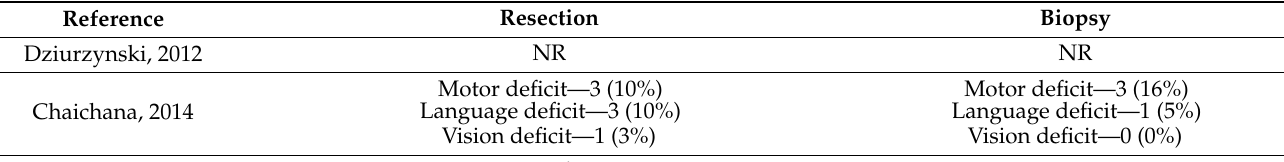
Table A1. Post-operative complications compared by